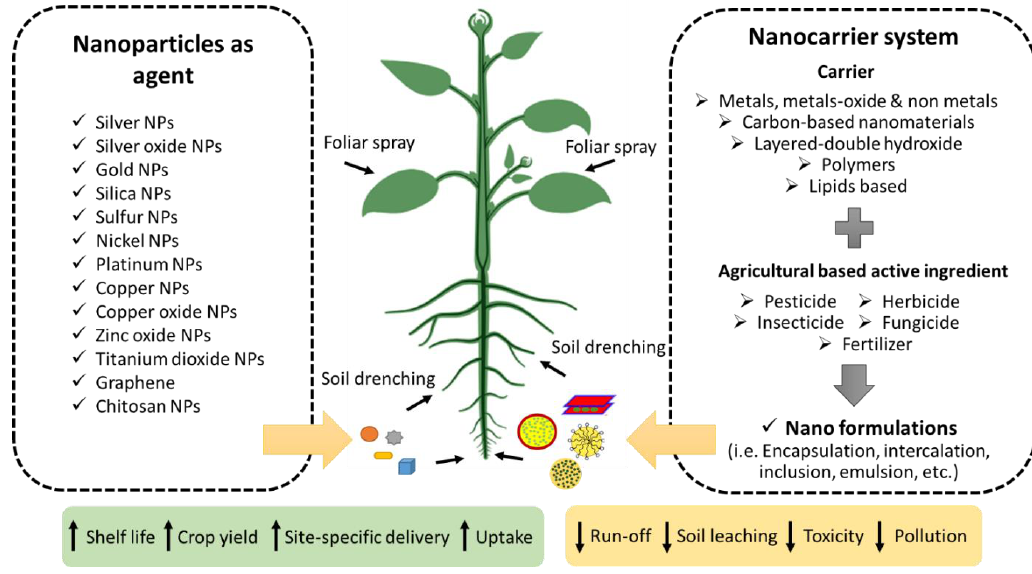
Figure 2. The use of nanoparticles in crop science.